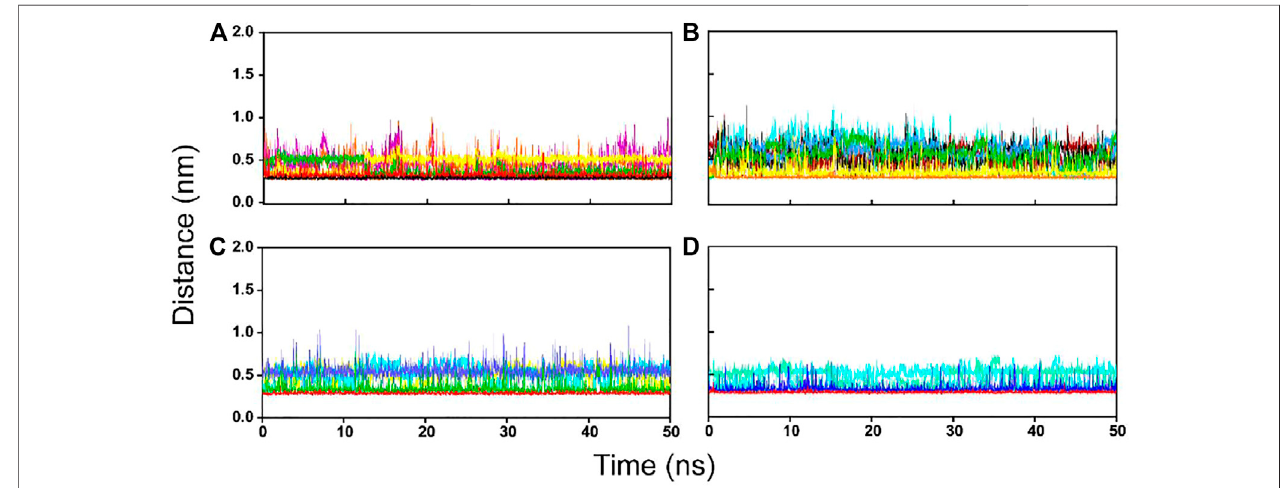
FIGURE 8 | The inter-molecular hydrogen bond dynamics of PLpro-hit complexes during the MD simulation. (A) Hit 1. (B) Hit 2. (C) Hit 3. (D) Hit 4.